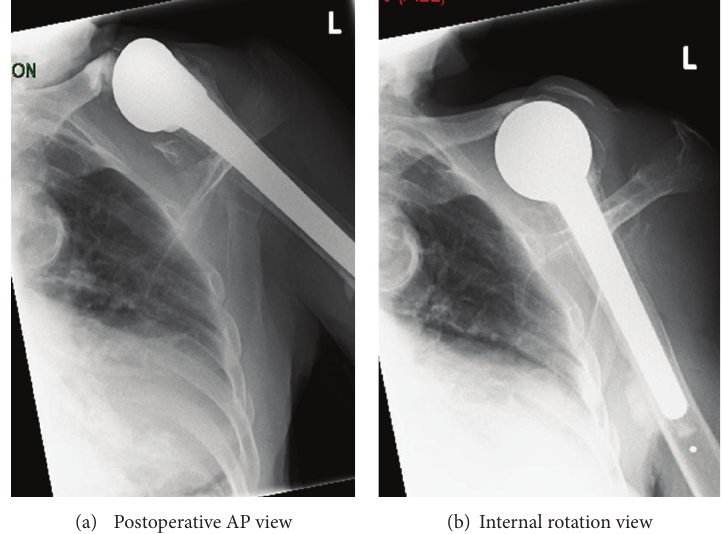
Figure 2: Postoperative AP and internal rotation views of the left shoulder. Note the trimmed clavicle and the lack of gas in the soft tissues following successful